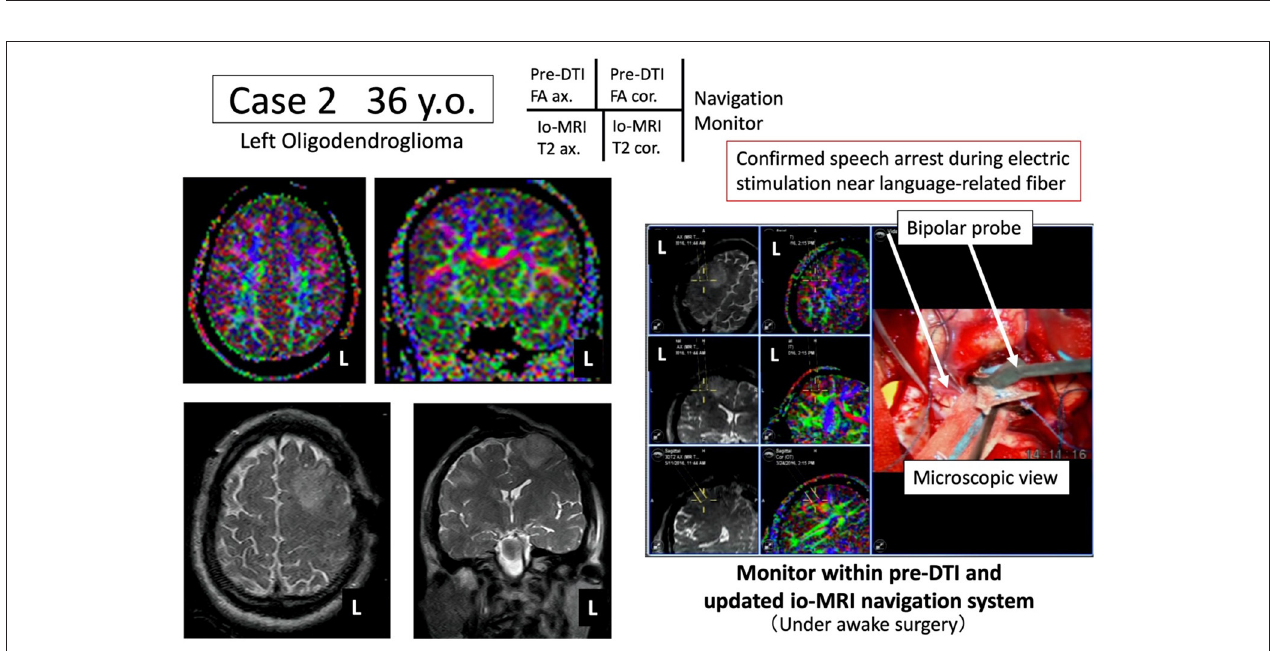
FIGURE 2 | Case 1: navigation based on pre-operative pyramidal tract motor function information. Under general anesthesia, tumor resection is advanced while the pyramidal tract (blue) is monitored in real time using the newly developed navigation system.